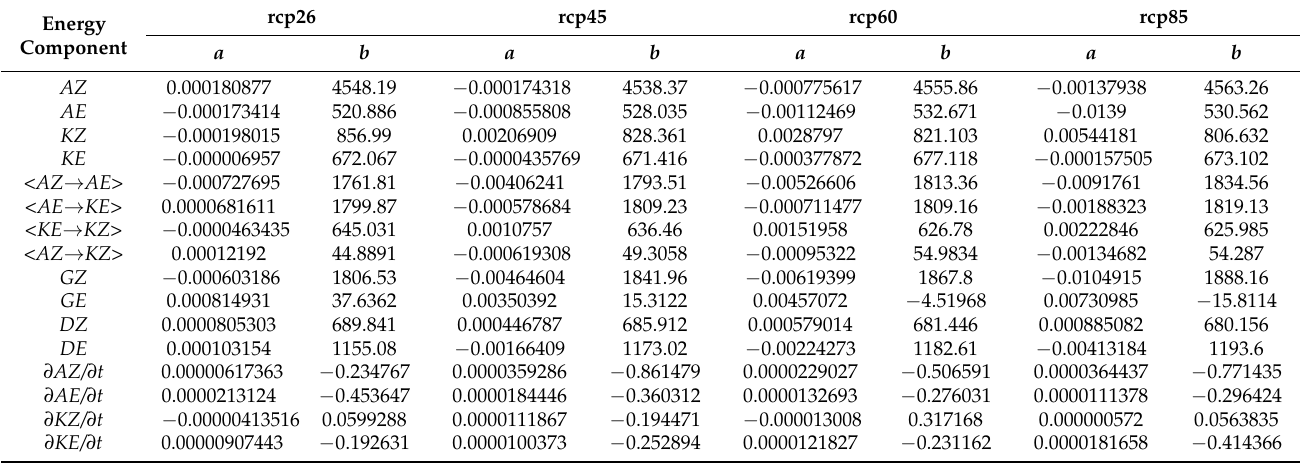
Figure 6. Same as Figure 3 but for KE . Table 3. The numerical values of the constants in the regression equation X = a d + b , where X denotes an energy component and d is number of the day in the 2020–2110 period.